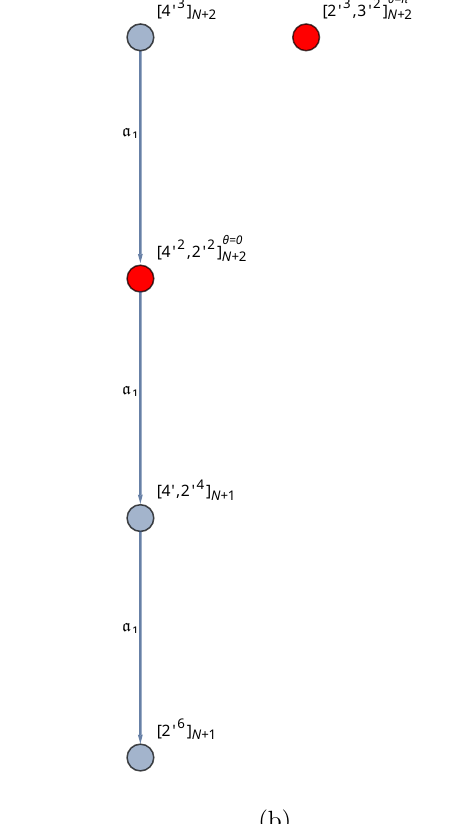
˜ E 1 -theories with n 0 = 8 and k = 38 ; there are two -theories with n = 9 and k = 39 ; there is a single 0 0